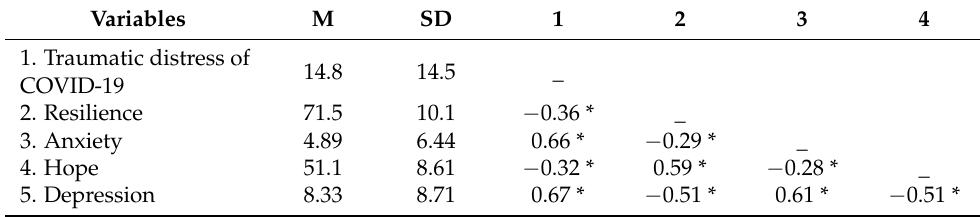
Figure 2. Mediation analyses predicting depression. Values on paths represent standardized β coefficients. Values on endogenous variables represent variance. Value in parenthesis represents the direct effect after considering all mediators in the model. All values are significant.